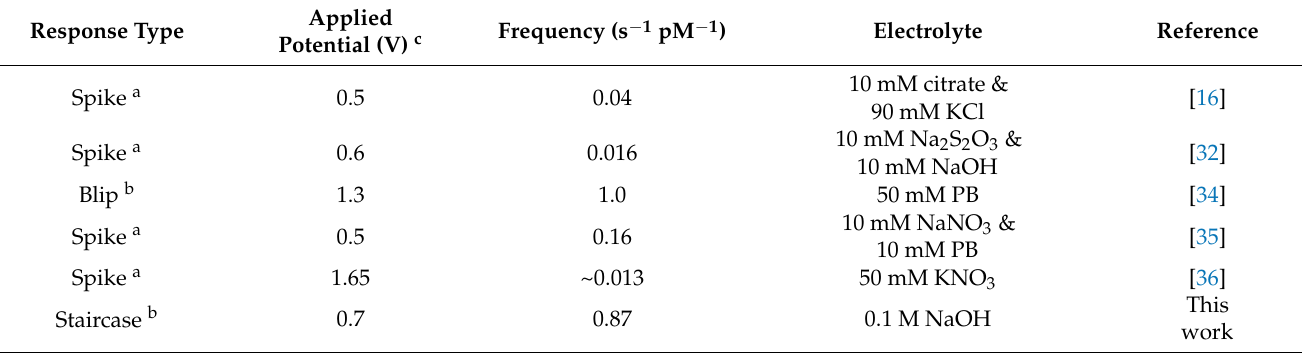
Table 2. Comparison of signal frequency and peak height of current response of a single Ag NP